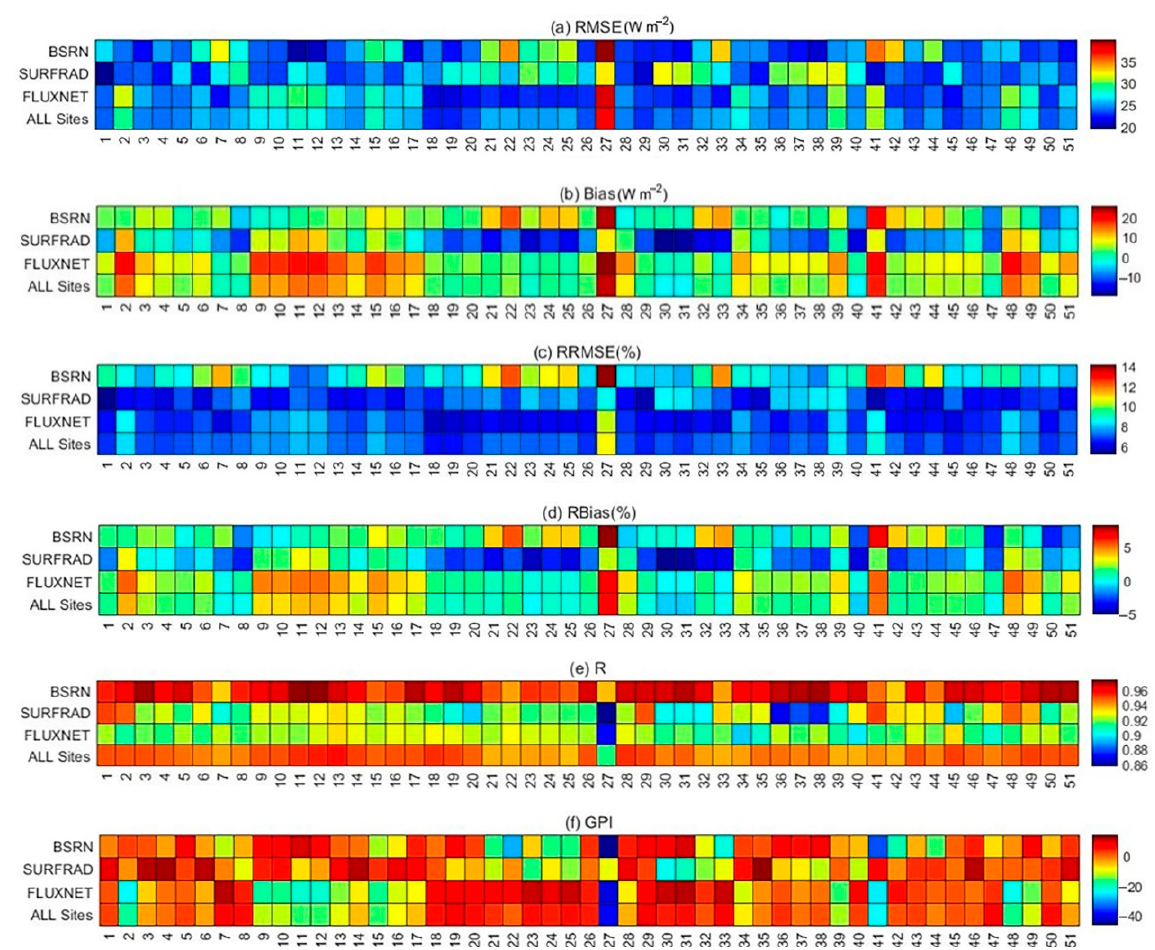
Figure 2. Diagrams of the statistical metrics (root mean squared error (RMSE) ( a ), mean bias error (Bias) ( b ), relative root mean squared error (RRMSE) ( c ), relative mean bias error (RBias) ( d ), correlation coefficient (R) ( e ), and global performance indicator (GPI) ( f )) of the comparison between the surface upward longwave radiation (SULR) simulations from the 51 CMIP6 GCMs and the SULR measurements for the Baseline Surface Radiation Network (BSRN), Surface Radiation Budget Network (SURFRAD), FLUXNET2015 (FLUXNET), and all 133